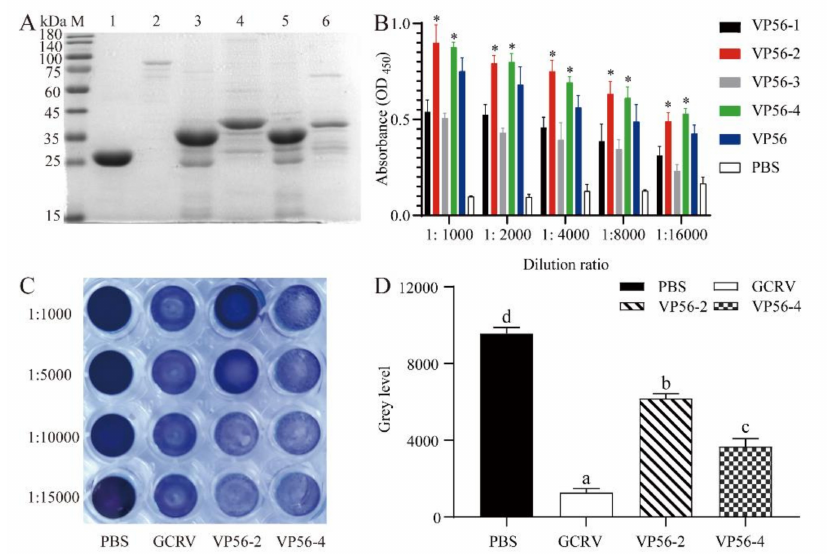
Figure 1. Screening VP56 epitopes. ( A ) SDS-PAGE to detect the full-length and fragment protein expression of VP56. Lane M: protein Marker; Lane1-6: GST as control, VP56 (81 kDa), VP56-1 (32 kD), VP56-2 (43 kD), VP56-3 (31 kD), VP56-4 (42 kD). ( B ) ELISA experiments of full-length and